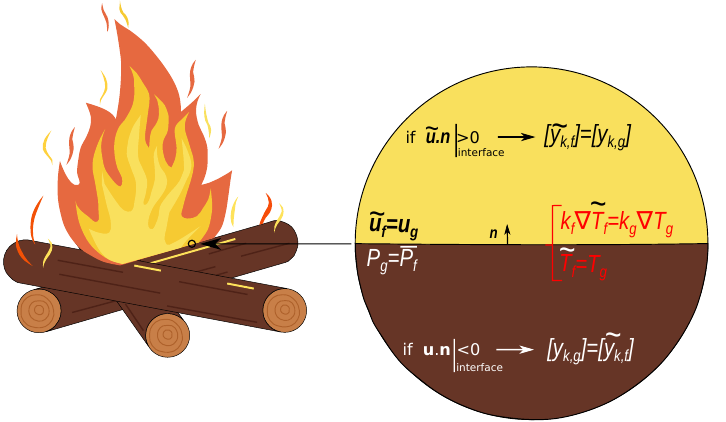
Figure 3. Illustration of the numerical boundary conditions for the coupling between the two regions. Conditions for the velocity, temperature, pressure and species concentration need to be